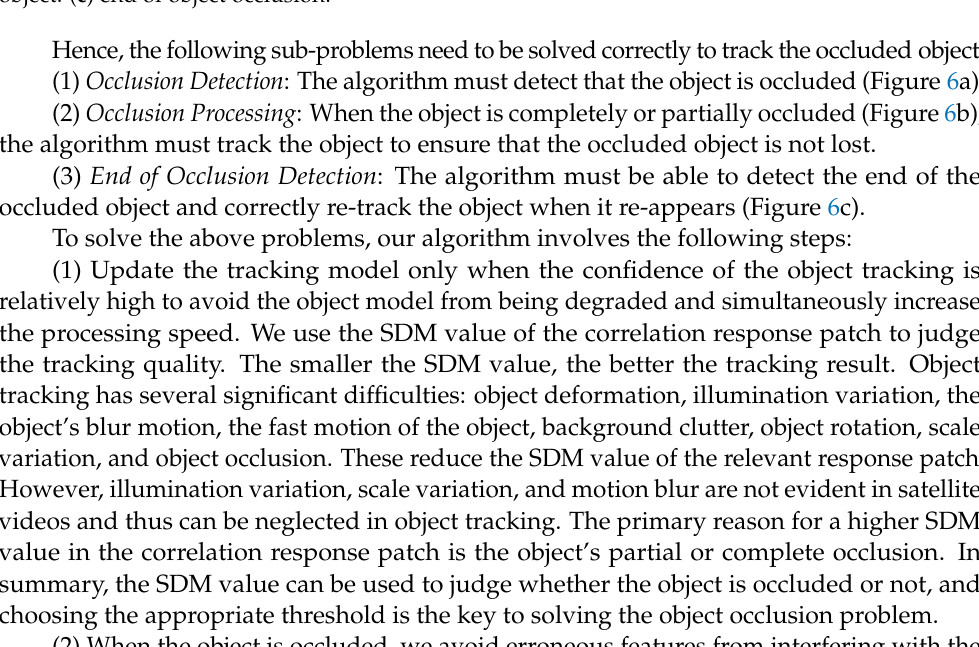
Figure 6. Visualization of an object occlusion process. ( a ) not occluded object. ( b ) partially occluded object. ( c ) end of object occlusion.